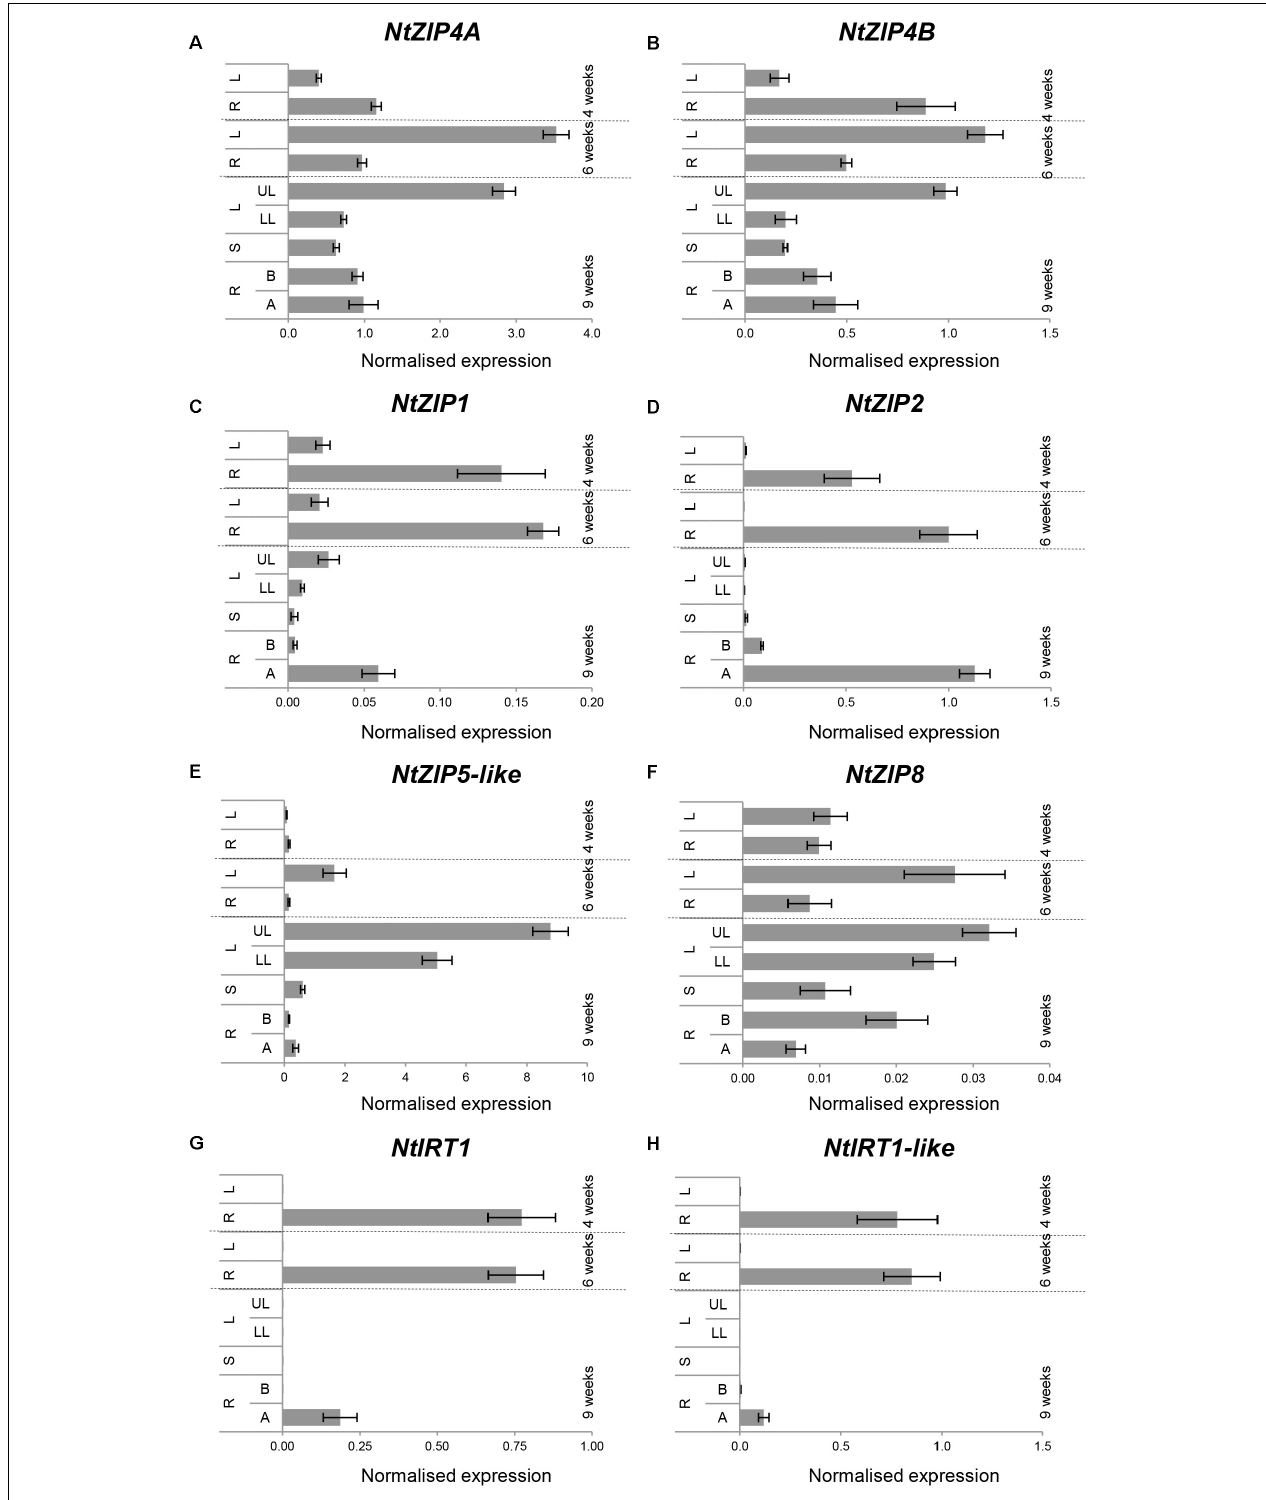
FIGURE 4 | Organ- and developmental-regulation expression of selected ZIP genes in N. tabacum (A–H) . Analysis was performed by RT-qPCR. Plants were grown at control medium. Transcript levels were monitored in the whole roots and leaves of plants grown for 4 and 6 weeks, and after 9 weeks in the apical (A) and basal (B) segments of roots (R), in stems (S), in young upper leaves (UL), and old lower leaves (LL). The level of genes transcript was normalized to PP2A expression level. Values correspond to means ± SD ( n = 3); those with the ratio greater than two are considered significantly different.